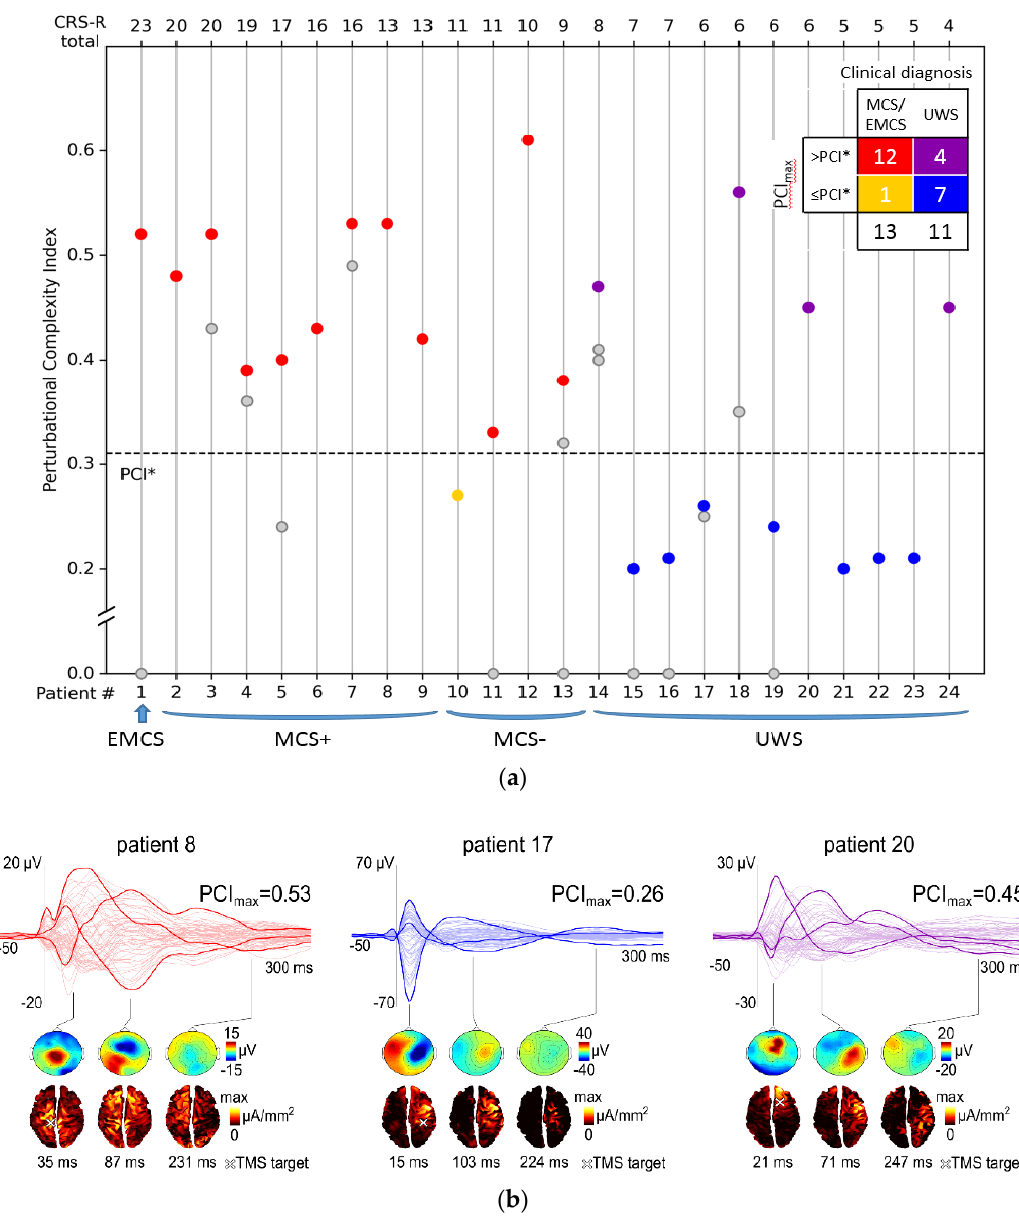
Figure 1. ( a ) Distribution of perturbational complexity index (PCI) values computed from patients with disorders of consciousness: unresponsive wakefulness syndrome (UWS), minimally conscious state (MCS+/ − , according to [21]), emergence from MCS (EMCS). The dashed horizontal line corresponds to the empirical cutoff (PCI*) previously validated in a large benchmark population to discriminate between unconsciousness and consciousness [18]. Multiple PCI values computed in single patients are aligned along vertical lines. Within each diagnostic category, patients are sorted by decreasing Coma Recovery Scale-Revised (CRS-R) total score. Gray circles represent submaximal PCI values, whereas individual maximum PCI values (PCI max ) are depicted by colored circles. The contingency table displayed in the upper right corner summarizes how many patients for each diagnostic category show a PCI max value either > PCI* or ≤ PCI*. ( b ) Top row shows the average transcranial magnetic stimulation (TMS)-evoked potentials (all channels superimposed, with 3 illustrative channels highlighted in bold) together with the PCI max values for three representative patients: a high-complexity minimally conscious state (MCS) patient (red traces), a low-complexity unresponsive wakefulness syndrome (UWS) patient (blue traces) and a high-complexity UWS patient (purple traces). For each patient, voltage scalp topographies (second row) and significant current density cortical maps (third row) are shown at three selected time points. A white cross on the cortical map indicates the stimulation site.